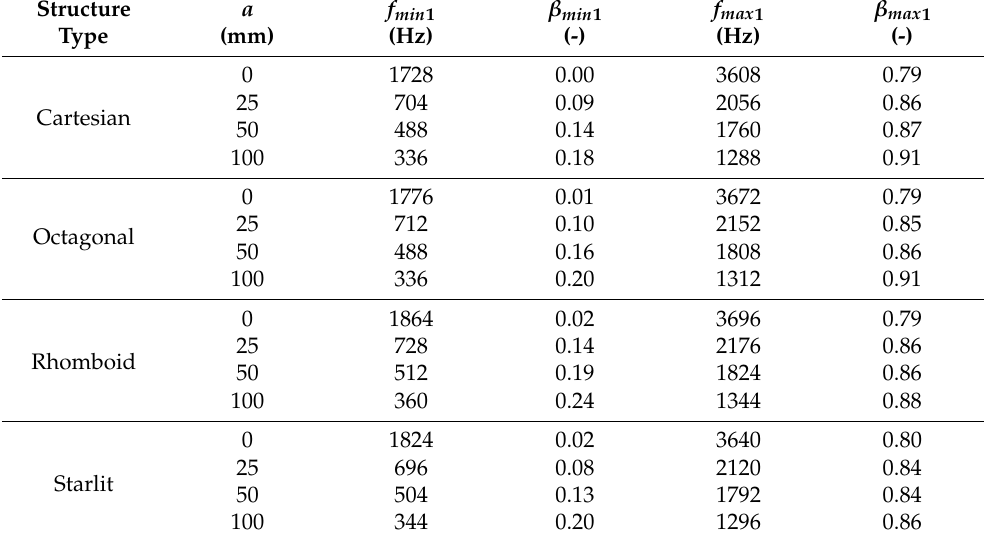
Table 3. Primary sound reflection minima and maxima and their corresponding excitation frequencies depending on the air gap size for the studied 3D-printed open-porous PLA material structures of thickness t = 30 mm and porosity P =